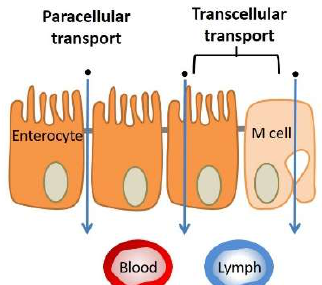
Figure 2. Absorption mechanisms through the mucosal layer. Paracellular route to lamina propia and transcellular route (enterocytes, M-cells, transfection of the epithelial cells, direct absorption through dendritic cells and active transport).